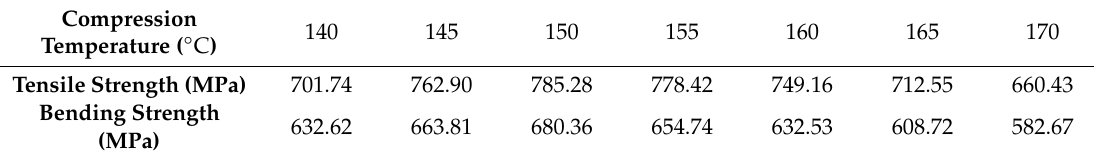
Table 7. E ff ects of compression temperature on mechanical performance.